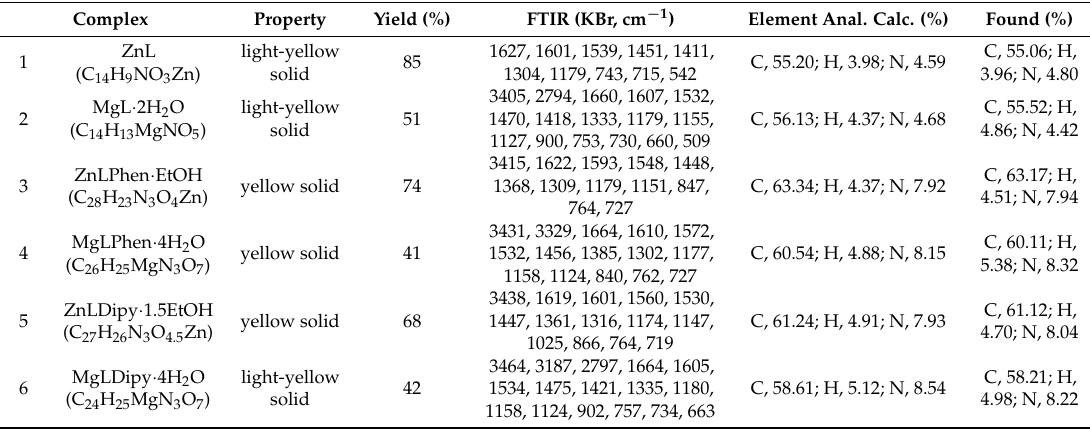
Table 3. Basic properties of the prepared